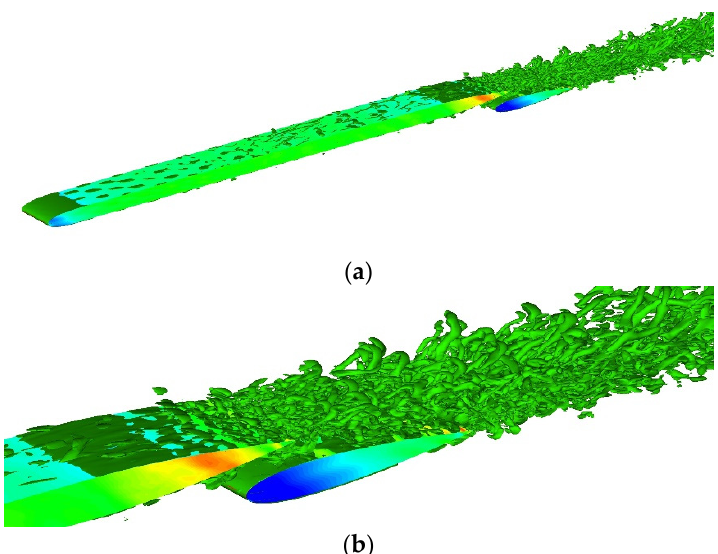
Figure 5. z-direction vorticity contours.